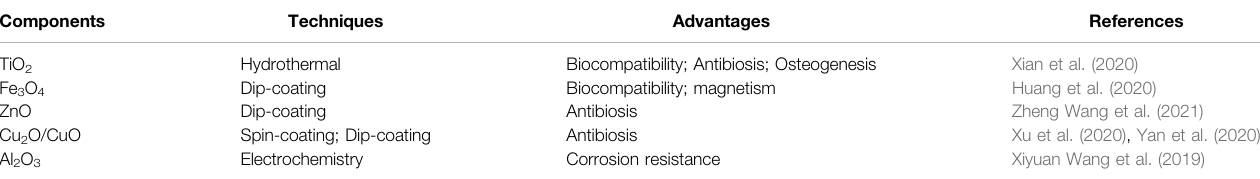
TABLE 2 | Metallic oxides applied in PDA-based multifunctional